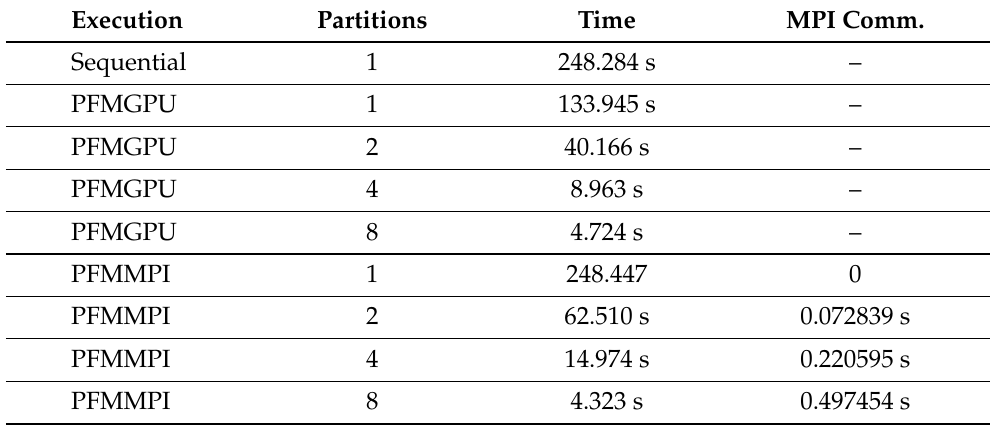
Table 4. Runtimes for the complete schools